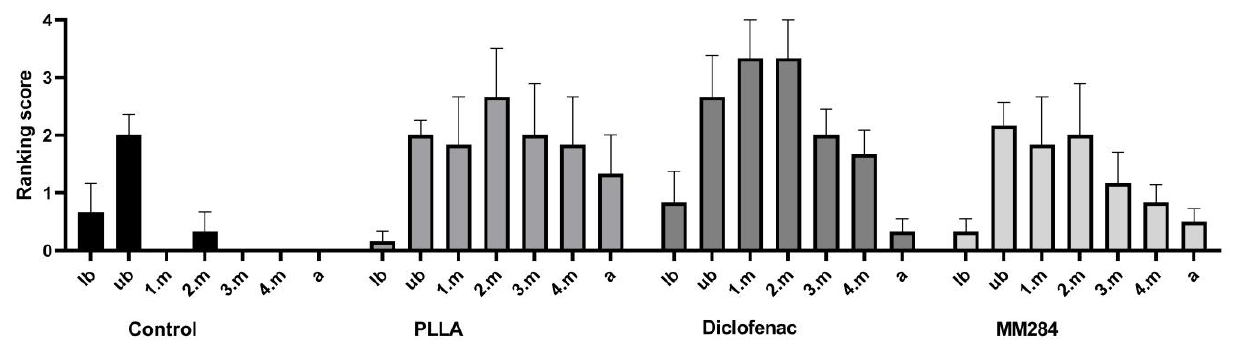
Figure 6. Connective tissue growth in the turns of the cochlea. lb = lower basal turn, ub = upper basal turn, 1.m = 1st middle turn, 2.m = 2nd middle turn, 3.m = 3rd middle turn, 4.m = 4th middle turn, a = apical turn. Mean ± SEM, Ranking scores according to Table 2. There were no significant differences between the PLLA group and the diclofenac and MM284 groups.